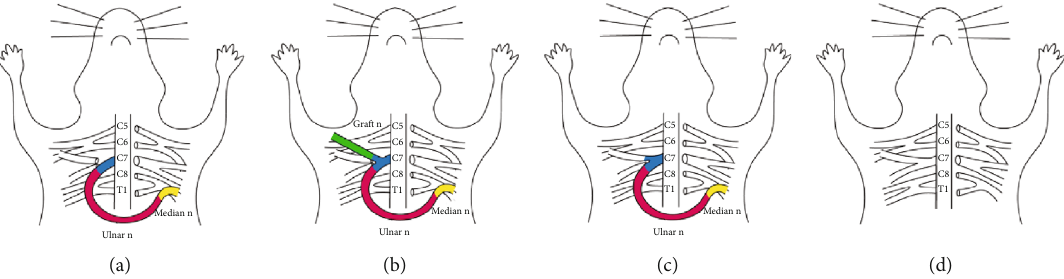
Figure 2: Transfer of entire root, posterior division, and entire root+posterior division. (a) In the entire root group, the entire right CC7 nerve root was transected at the trunk to the division level to be coapted with the ulnar nerve in the left side with no intension by 11-0 microsutures. (b) In the entire root+posterior division group, the entire right CC7 nerve roots were transected at the division level and only the posterior division was coapted with the ulnar nerve in the left side with no intension by 11-0 microsutures. The anterior division was transferred to the pectoralis major bridged by the medial antebrachial cutaneous nerve on the a ff ected side. (c) In the posterior division group, only the posterior division of the right CC7 nerve root was transected and coapted with the ulnar nerve in the left side with no intension by 11-0 microsutures. (d) In the blank control group, the total left brachial plexus was avulsed and the right brachial plexus was only exposed with no operation